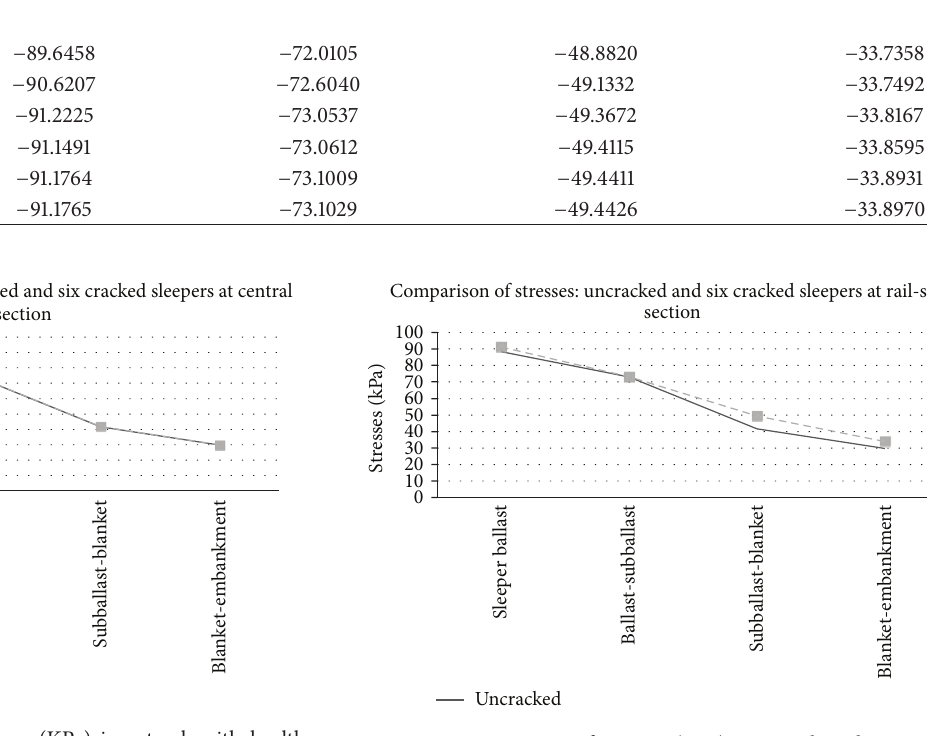
Figure 8: Comparison of stresses (KPa) in a track without cracks and a track with six cracked sleepers at rail-seat